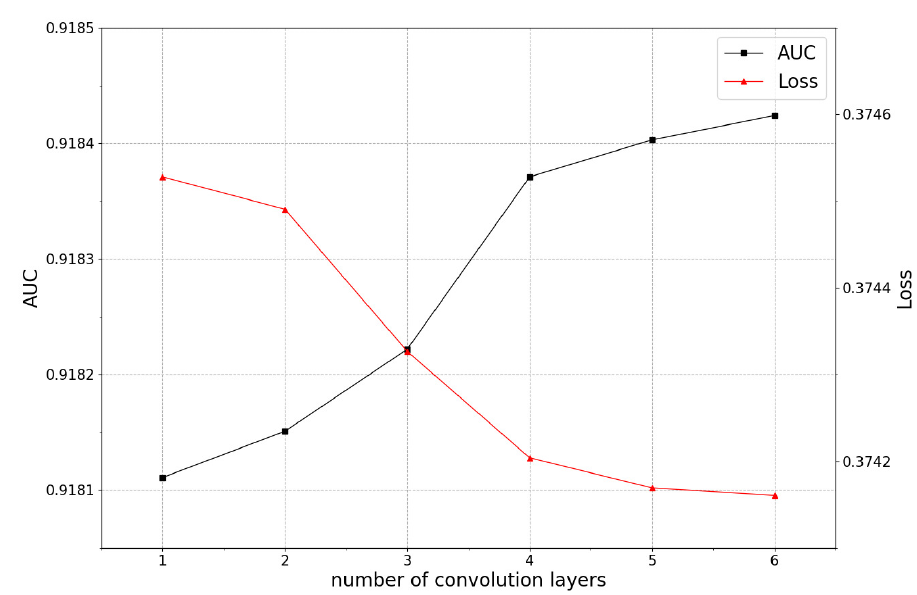
Figure 7. The impact of the number of convolution layers on model